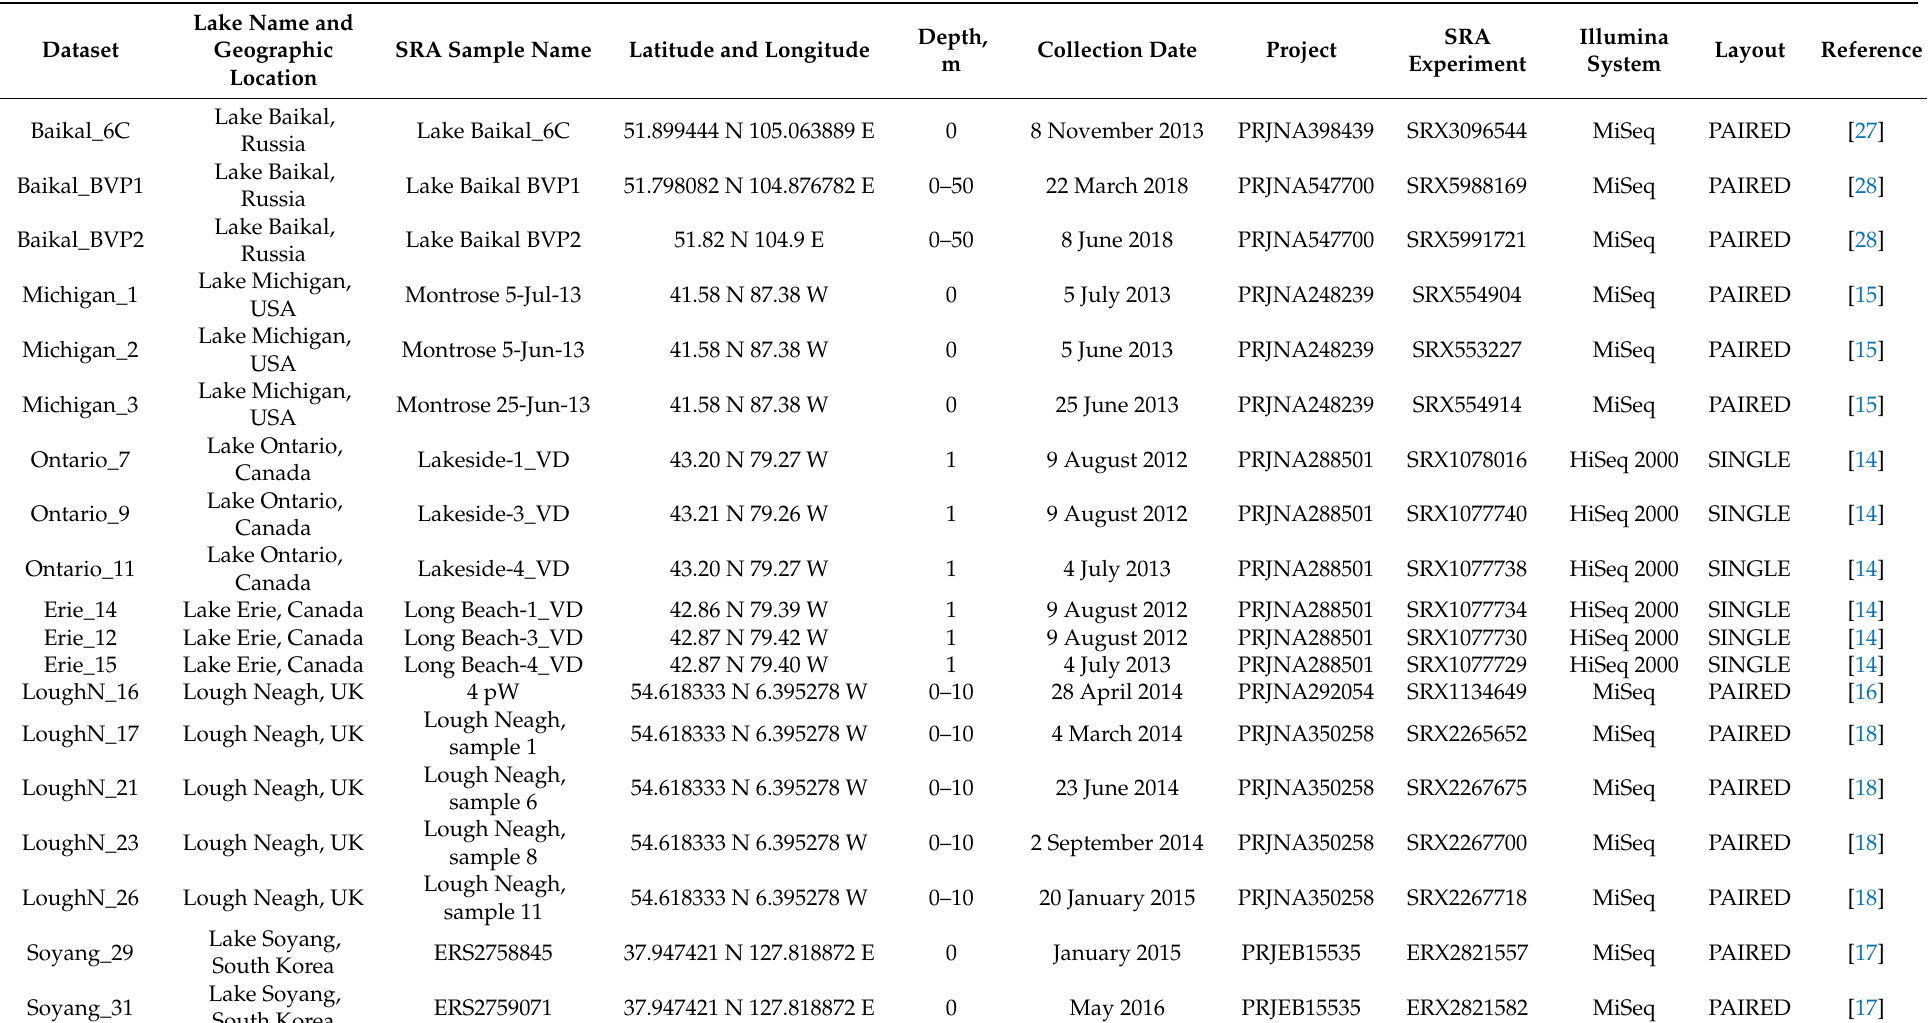
Table 2. Description of reference virome datasets used for